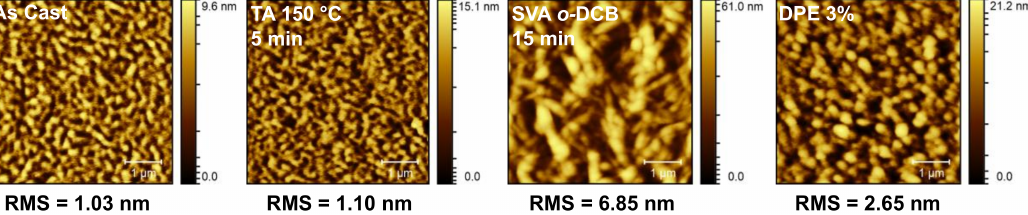
Figure 9. Atomic force microscopy (AFM) images for OSC devices with PBDB-T/ 1 (50:50) active layers measured “as cast,” thermally annealed (TA) at 150 ◦ C for 5 min, solvent vapor annealed (SVA) from o -DCB for 15 min, and processed with a diphenylether (DPE) 3% (v/v)